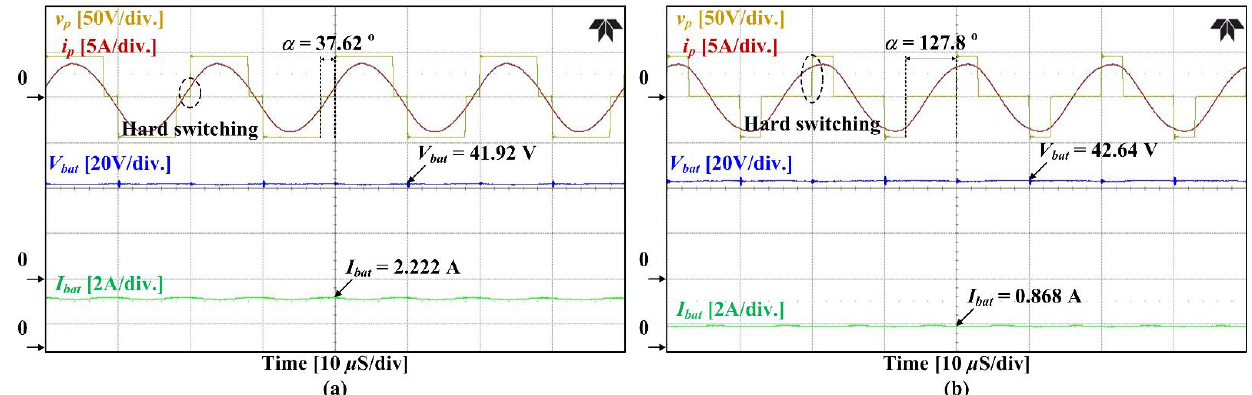
Figure 11. Experimental waveforms when the proposed WPT circuit operates in the CV mode with f s = f o at ( a ) R bat = 18.29 Ω, and ( b ) R bat = 41.53 Ω.